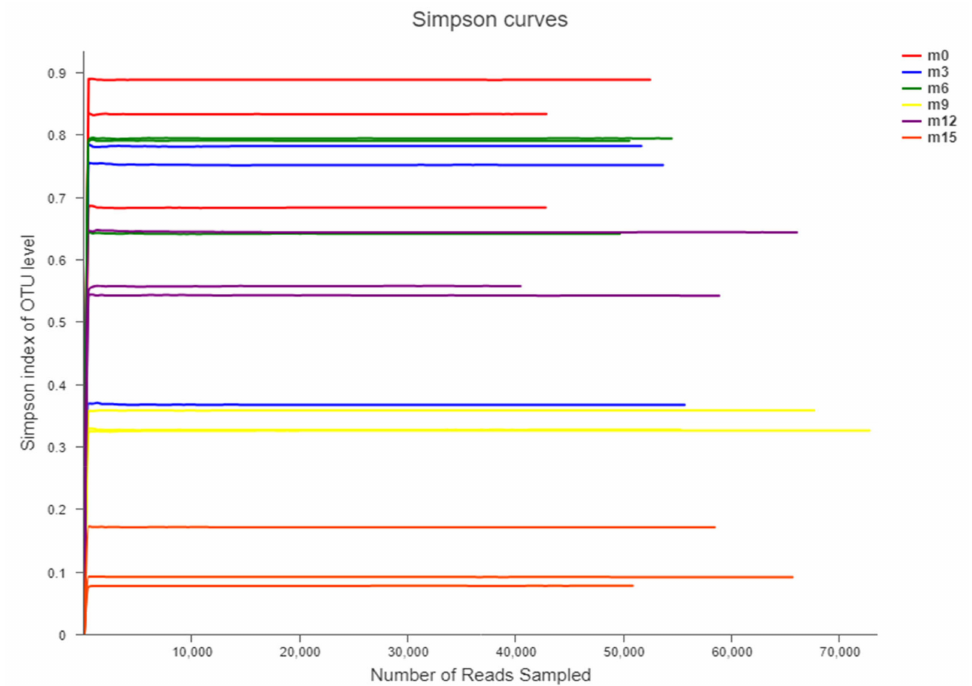
Figure 3. Rarefaction analysis of high-throughput sequencing reads of the bacterial 16S rRNA gene from 18 fish sauce samples. Rarefaction curves were constructed at a 97% sequence similarity cut-o ff value.